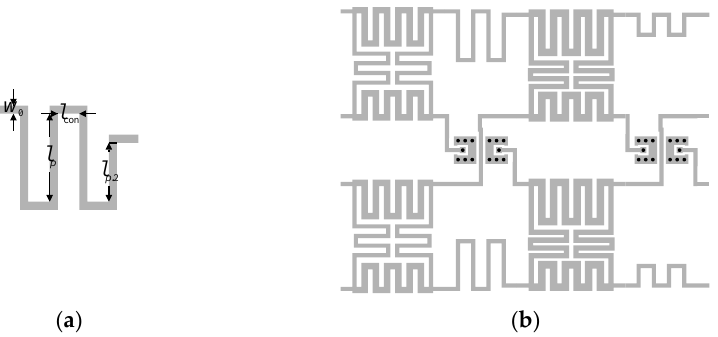
Figure 8. EM model responses of miniaturized BLC structures – magnitude (gray) and phase (black) at the initial (····) and optimized (––) designs: ( a ) BLC 1 (realized phase difference β 1 = −75°) and ( b ) BLC 2 (realized phase difference β 2 = −60°). Figure 9. Geometry of ( a ) phase shifter with highlight on design parameters and ( b ) assembled structure of a compact Butler matrix.